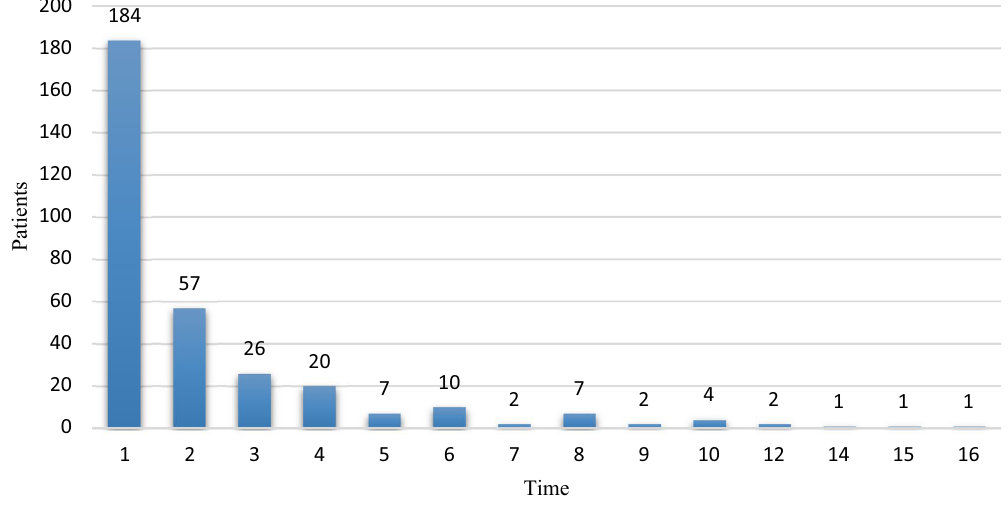
Figure 2. The number and time of occurrence of CIT based on